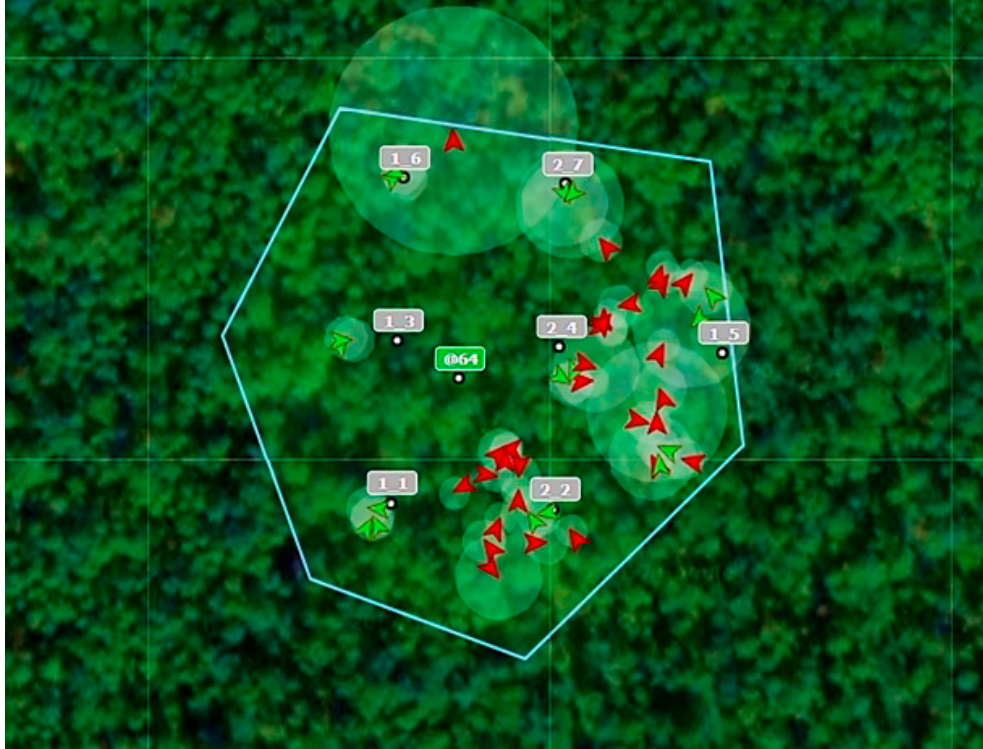
Figure 5. Image capture from the Trestima web service interface showing an example of a field sample plot shape and the samples’ visualization (green arrows correspond to basal area samples, and red arrows correspond to model tree diameter and height samples). The example plot includes several tree species, and therefore the number of model tree samples (red arrows) is large.